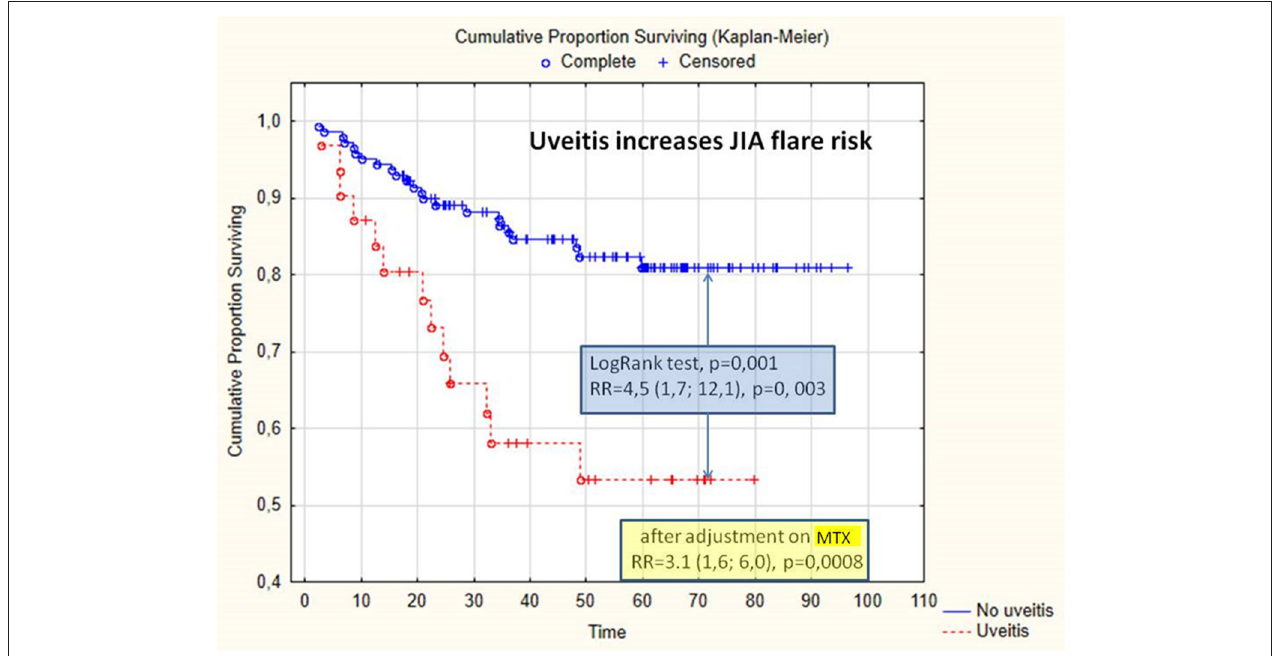
FIGURE 1 | Cumulative proportion of survival without arthritis flare, depending on the presence of uveitis. JIA, juvenile idiopathic arthritis; MTX, methotrexate; RR, relative risk.